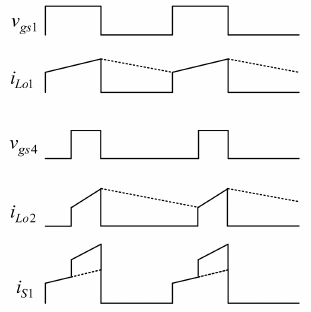
Figure 5. Leading-edge modulation technique.